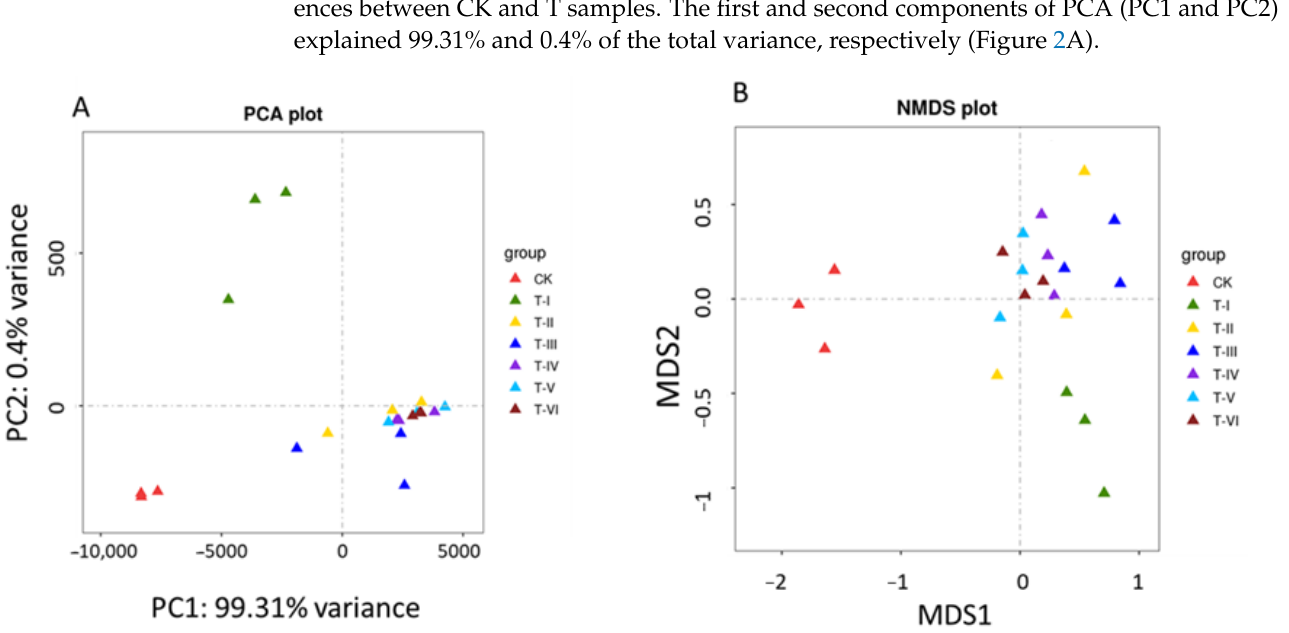
Figure 2. ( A ) PCA plot showing microbial diversity in groups, ( B ) Non-Metric Multidimensional Scaling (NMDS) plot showing variation in the microbial communities between different samples. (Sample codes indicate the samples fermented for 0 d (CK), 5 d (T-I), 10 d (T-II), 15 d (T-III), 20 d (T-IV), 25 d (T-V) and 30 d (T-VI)).